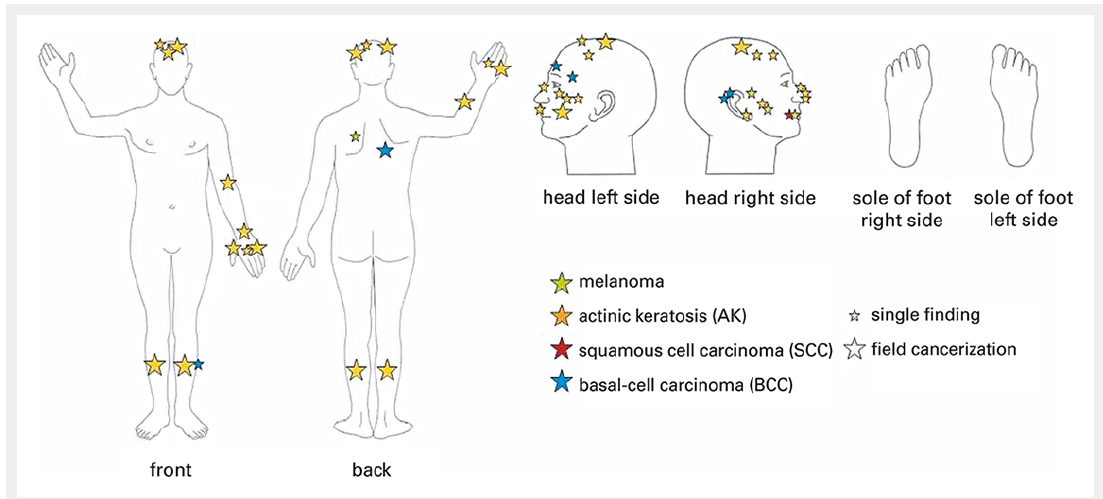
Figure 2 Graphical presentation of nonmelanoma skin cancer and its premalignant stages found during the full-body skin examination of all participants by a dermatologist. The size of the stars depicts the number of findings: a small star represents a single finding, a big star field